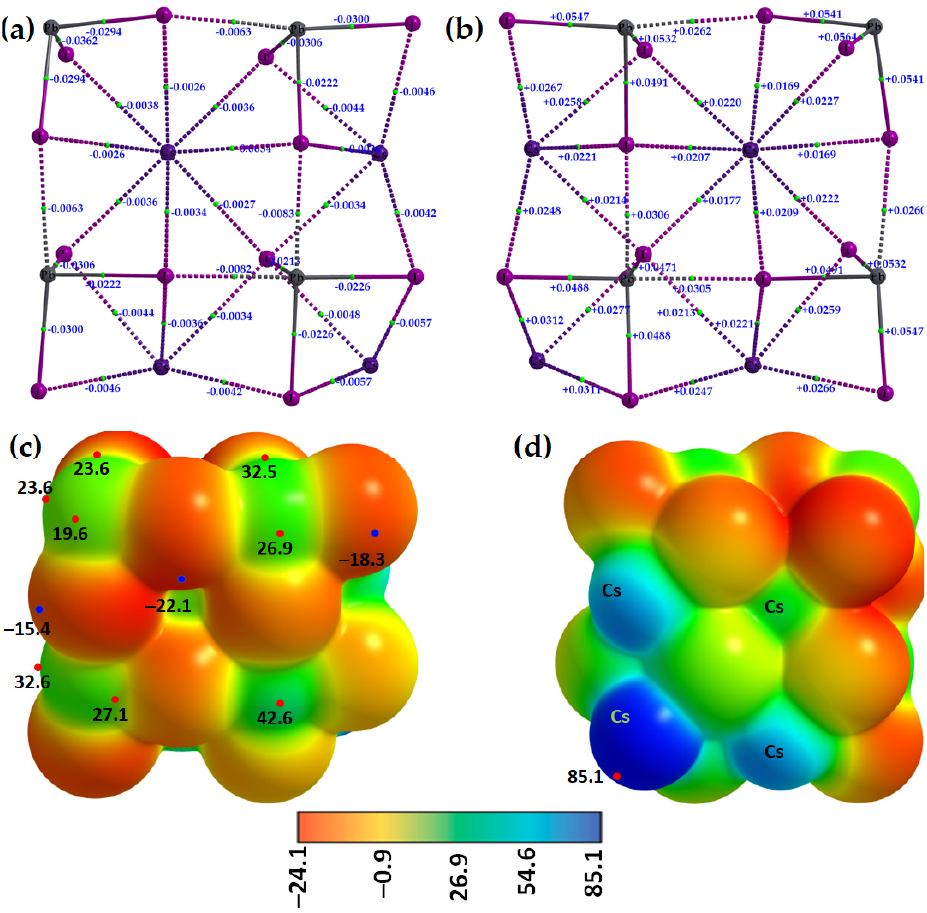
Figure 16. The QTAIM-based molecular graphs of the [Cs + •PbI 3 − ] 4 tetramer, showing the ( a ) potential energy density ( V b ) and ( b ) ∇ 2 ρ b values at various bcps. Atoms, bond paths, and bond critical points are shown as large spheres, solid/dotted lines in atom color, and tiny spheres in green, respectively. ( c , d ) represent two views of the same tetramer in which the Tt atoms in the former and the Cs atoms in the latter are facing the viewer. Selected local most maxima and minima of potential ( V S,max and V S,min ) represented by tiny circles in red and blue, respectively, are depicted in ( c , d ), with values shown in kcal mol − 1 . The atomic positions shown in the molecular graphs are the same as those in the MESP plots.